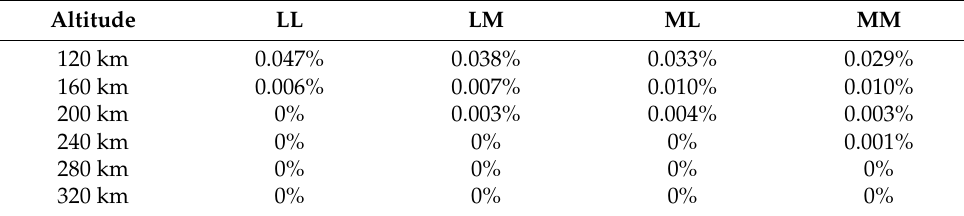
Table 12. Simulation results of the attitude control jet for different solar activities, geomagnetic activities, and altitudes.